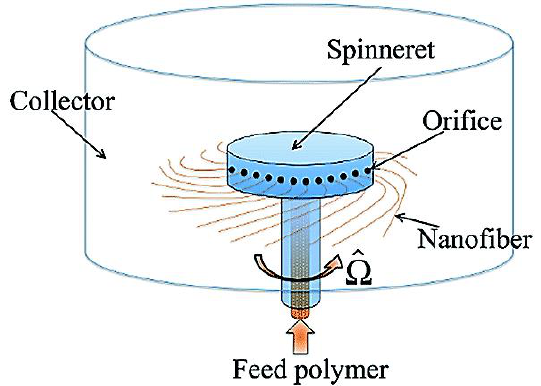
Figure 16. Basic centrifugal spinning system setup. Reproduced with permission from [144], copy- right 2014 American Physical Society.